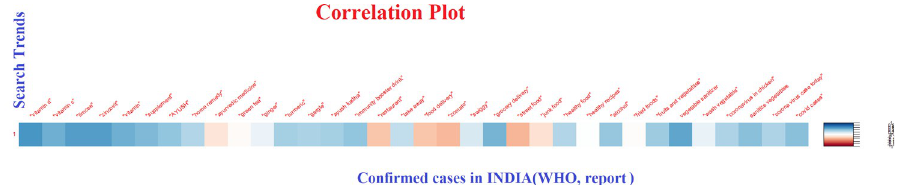
Fig 2. The correlation between the number of COVID cases and search terms (the darker the shade of blue the stronger is the correlation while the darker the shade of red the stronger negative correlation of each key word with the number of COVID